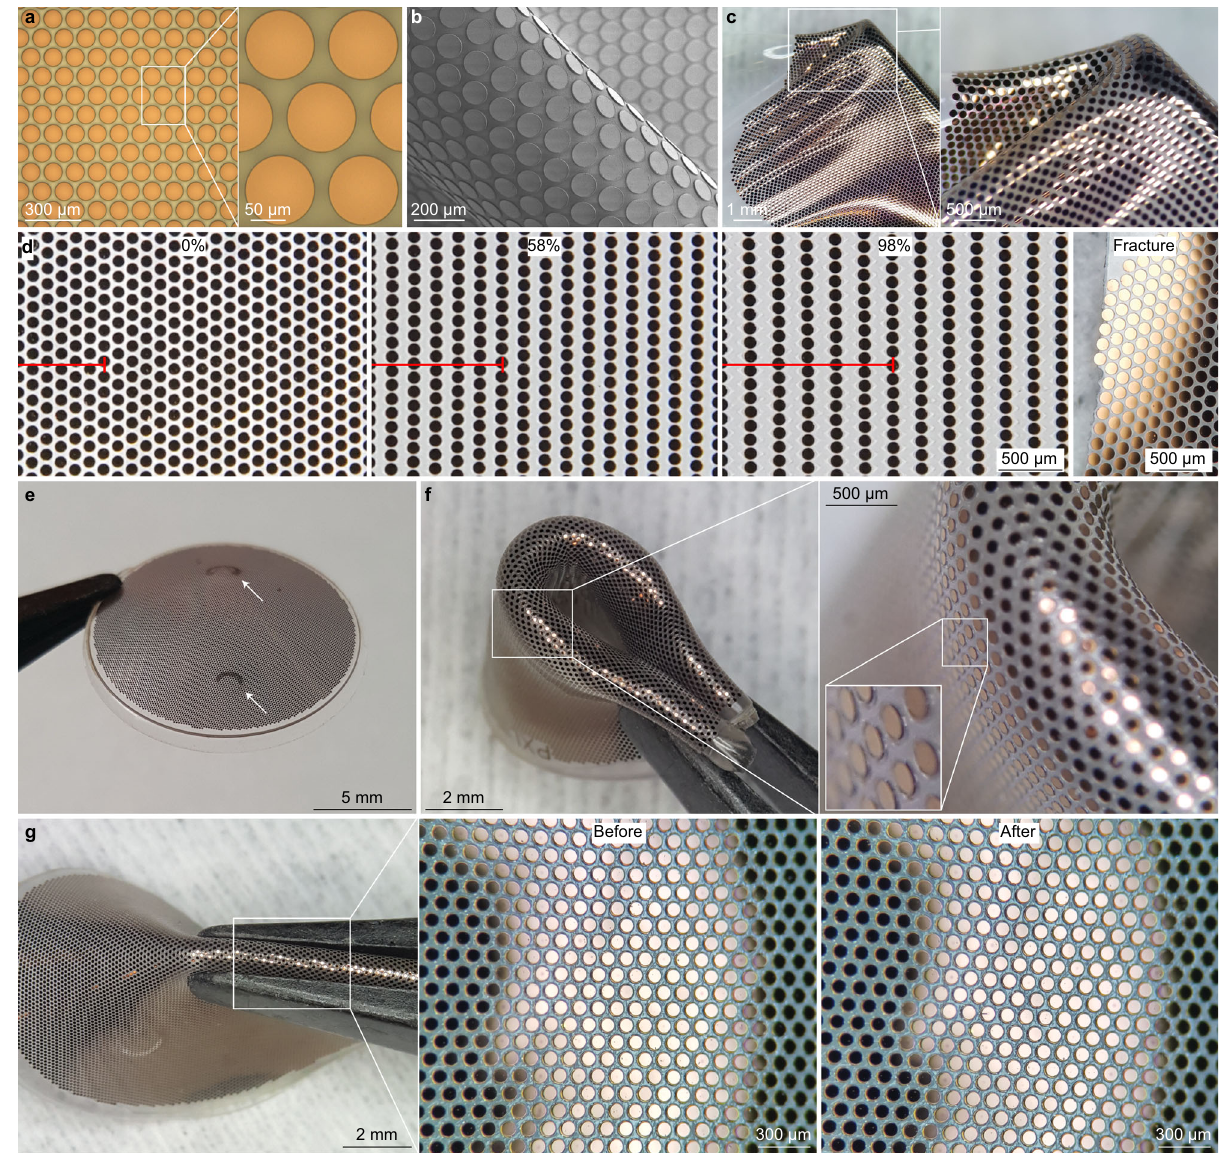
Fig. 4 Optimisation of the POLYRETINA device. a Picture of the photovoltaic pixels (100- µ m diameter and 120- µ m pitch). b Scanning electron microscopy picture of the photovoltaic pixels released from the wafer and folded to obtain tilted views on the pixels. c Image of a photovoltaic interface stretched and wrinkled with tweezers. d Pictures of the photovoltaic interface taken at 0, 54 and 98% of strain, and after fracture during a stretching test. The red bar shows six rows of pixels in the stretching direction. e Picture of a POLYRETINA. The white arrows indicate the points where tacks will be inserted. f Picture of a POLYRETINA folded four times. Images at various magni fi cations show that the photovoltaic pixels are intact during folding. g Picture of a POLYRETINA during pinching with magni fi cations on the intact photovoltaic pixels before and after pinching. Experiments in panels d , f – g have been reproduced in three